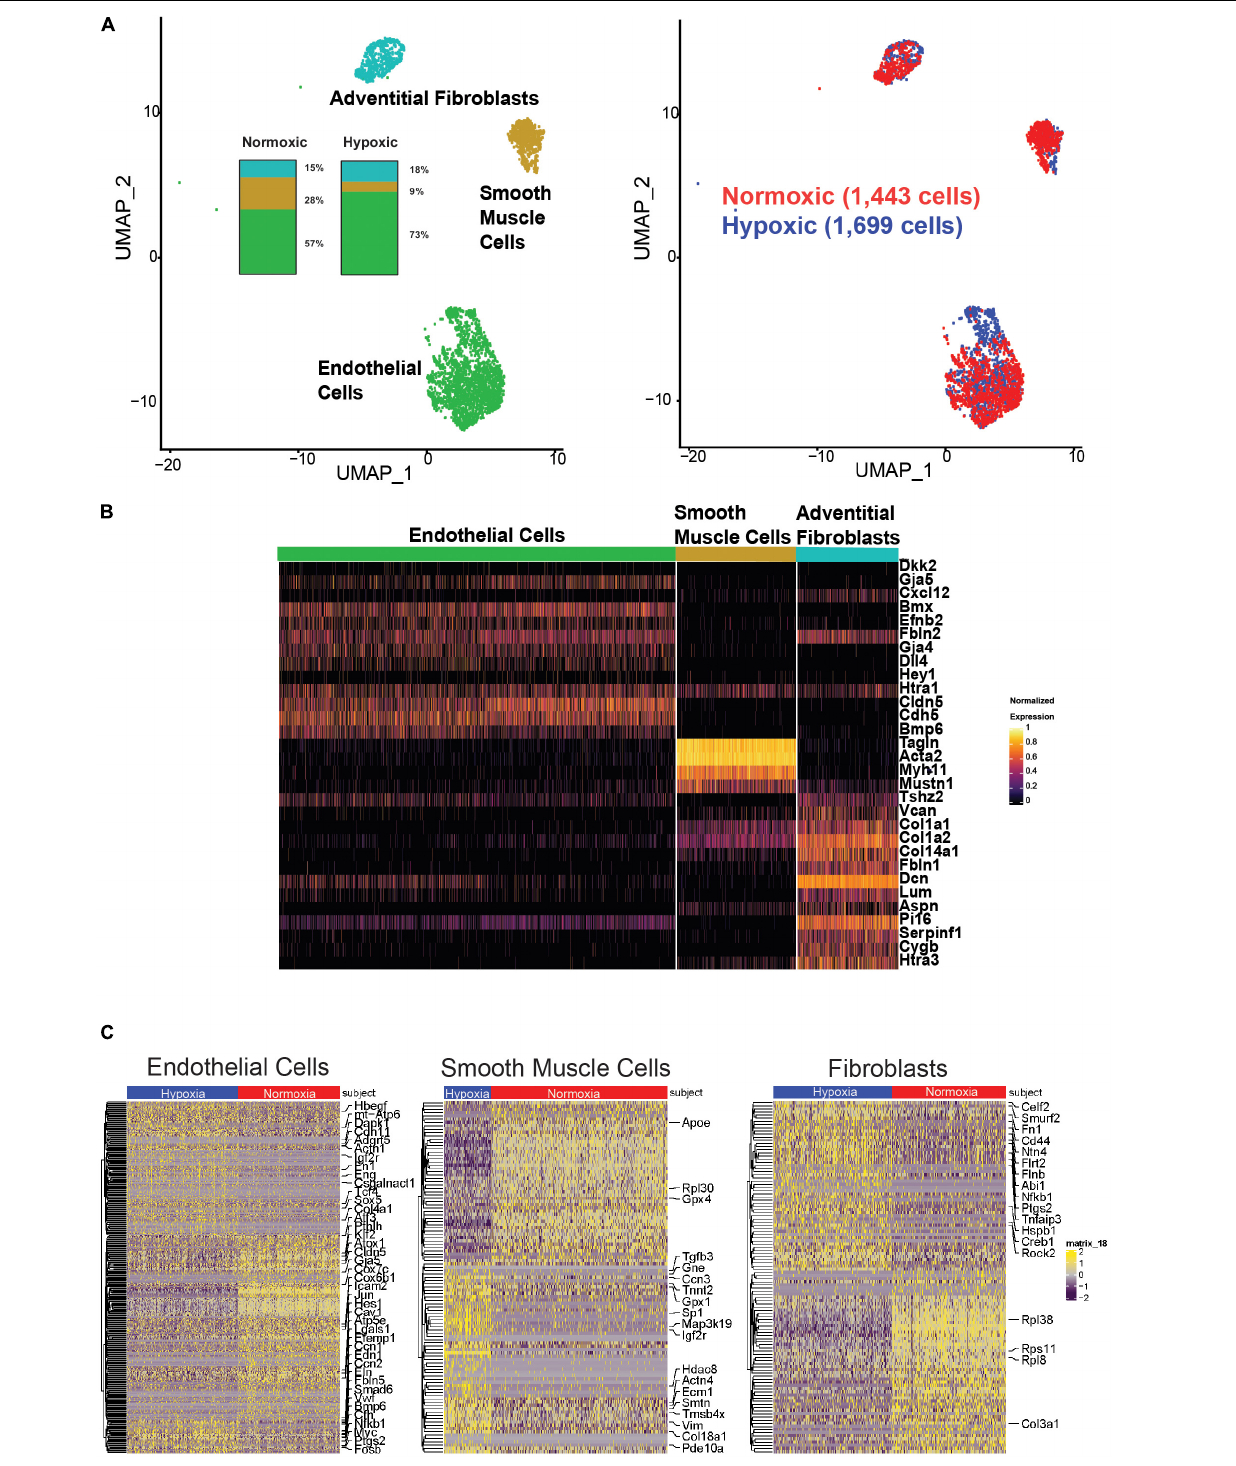
FIGURE 5 | Single cell RNA sequencing of mouse pulmonary artery resident cells. (A) Uniform Manifold Approximation and Projection (UMAP) representation of cells clustered by expressed genes. About 1,443 cells from hypoxic PA [1,053 endothelial cells (EC), 127 smooth muscle cells (SMC), 263 adventitial fibroblasts (FB)]. About 1,699 cells from normoxic PA (967 EC, 479 SMC, 253 FB). Although there are similar number of cells overall between normoxia and hypoxia samples, there is a decrease in the proportion of SMC in the hypoxia sample and an increase in the proportion of EC. (B) Heatmap identifies cell markers used to identify PA